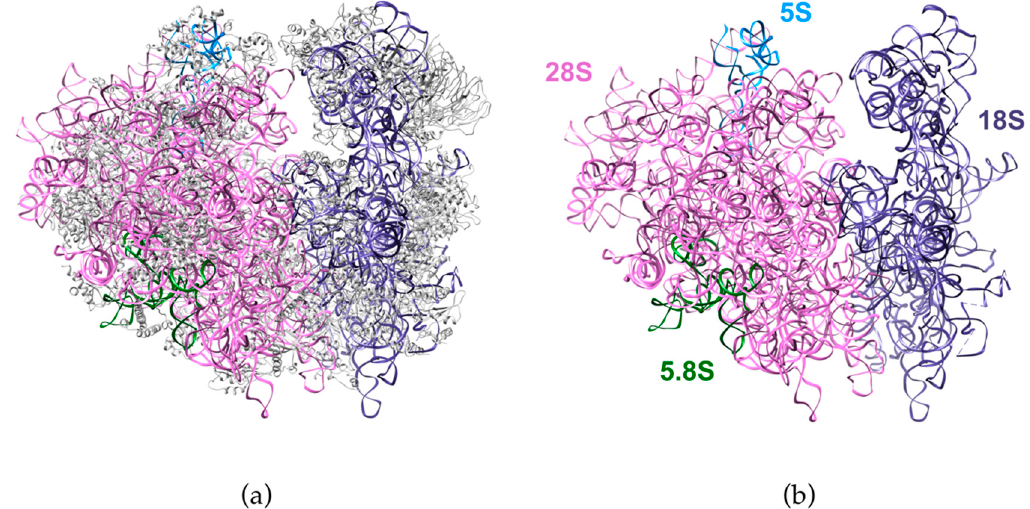
Figure 1. Structure of the human ribosome solved by cryo-electron microscopy. The figure shows the ribosomal RNAs in the large subunit (28S: pink, 5.8S: green, 5S: blue) and in the small subunit (18S: purple). ( a ) Structure with the ribosomal proteins (grey). ( b ) Ribosomal RNAs only. Adapted from Protein Data Bank (PDB) file 4UG0 [19].